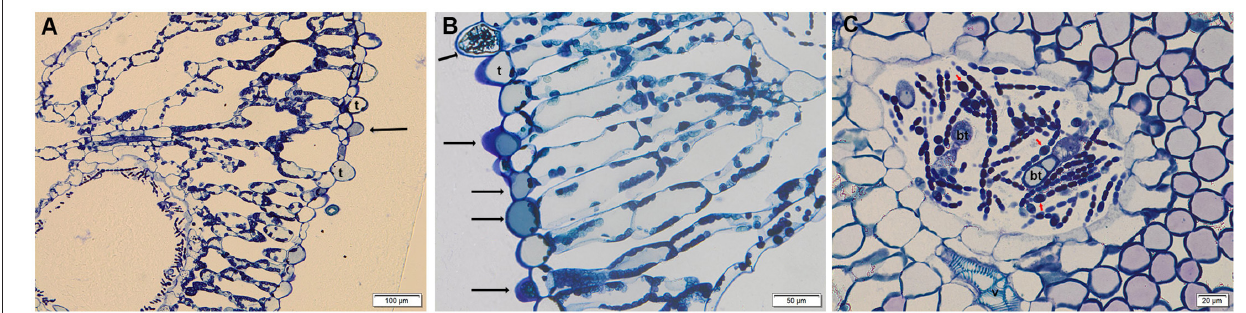
FIGURE 1 | Semithin transversal section of Azolla fronds stained with toluidine blue. (A,B) Single cell trichomes (t) in the leaf upper lobes; phenolic compounds are highlighted by black arrows in epidermal cells and trichomes. (C) Philamentous bacterium Trichormus in the leaf cavity, with some nitrogen-fixing heterocystis (red arrows); bicellular trichomes (bt), and vessels (v) are evident.